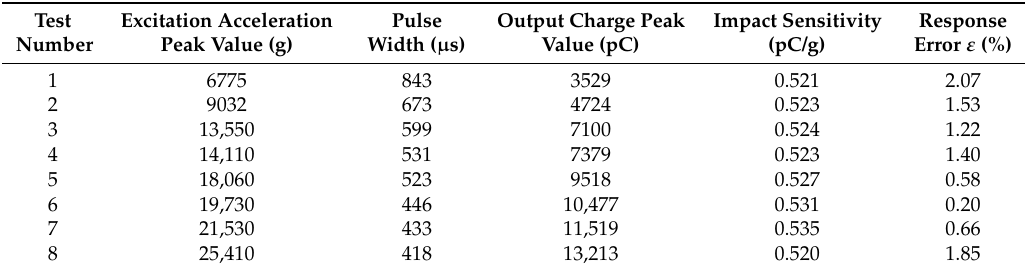
Figure 12. Excitation acceleration from laser interferometer and response acceleration from the accelerometer. Table 5. Calibration data of a high-g accelerometer.